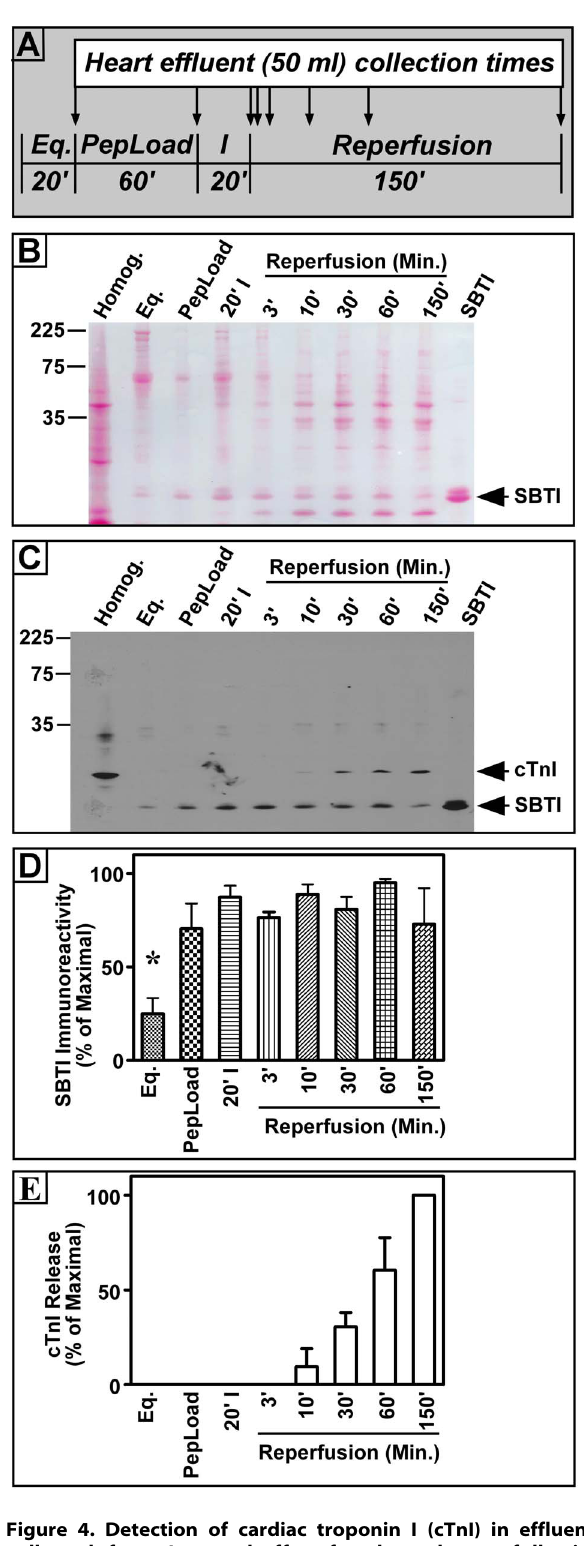
Figure 4. Detection of cardiac troponin I (cTnI) in effluents collected from Langendorff-perfused rat hearts following ischemia/reperfusion injury. Rat hearts were first given a 20 min equilibration (Eq) period, followed by a 1 hr perfusion (which will serve as the peptide loading phase (PepLoad), but no peptide was added for experiments in this figure). Next, hearts were given a 20 min global ischemia (I) exposure followed by 2.5 hr of perfusion with oxygenated Kreb’s buffer (Reperfusion). Effluents (50 ml) were collected from